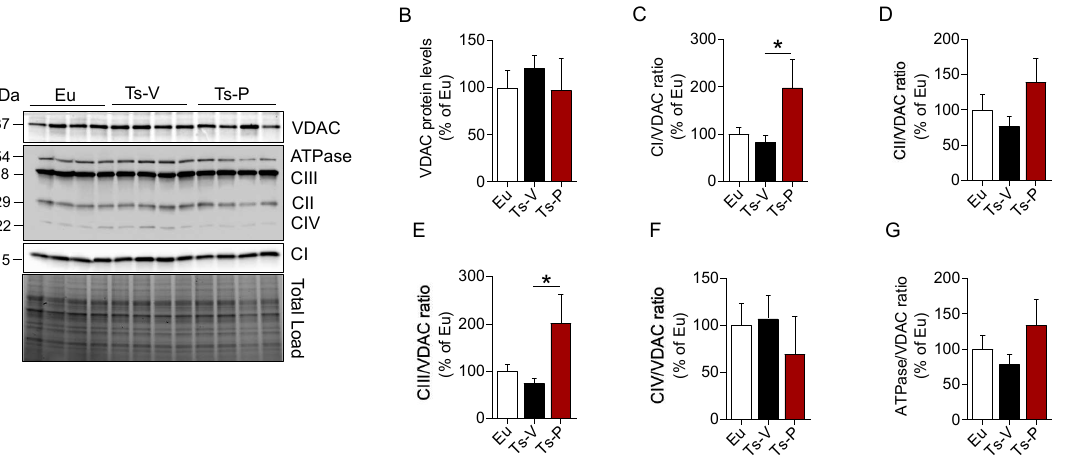
Figure 4. Changes of mitochondrial proteins following KYCCSRK intranasal administration in Ts2Cje mice. Mitochondrial OXPHOS complexes and VDAC protein levels were evaluated in the frontal cortex of Eu and Ts2Cje (Ts-V) mice treated with vehicle (saline) and Ts2Cje (Ts-P) mice treated with KYCCSRK peptide (0.5 mM) for two weeks (n = 4/group). ( A ) Representative Western blot and total load images and densitometric evaluation of ( B ) VDAC protein levels, ( C – G ) mitochondrial complexes (I–IV) and ATPase related to VDAC. All densitometric values were normalized per total protein load and are given as a percentage of Eu set as 100%. Data are shown as mean ± SEM. One-way ANOVA with Dunnett test: * p < 0.05.